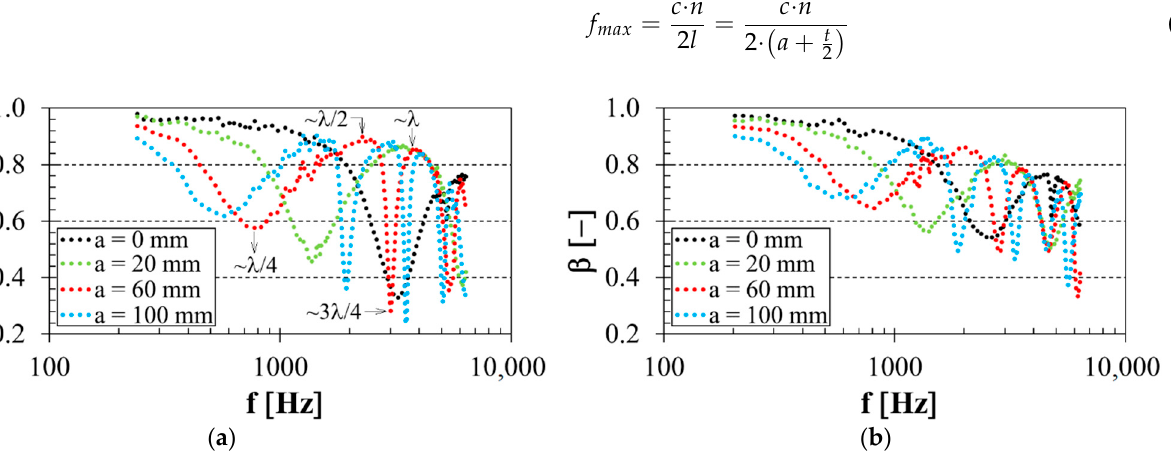
Figure 7. Influence of air gap size on the frequency dependencies of the sound reflection coefficient for the studied PLA specimens: ( a ) Starlit structure, sample thickness t = 20 mm, porosity P = 43%; ( b ) Cartesian structure, sample thickness t = 20 mm, porosity P = 56%.